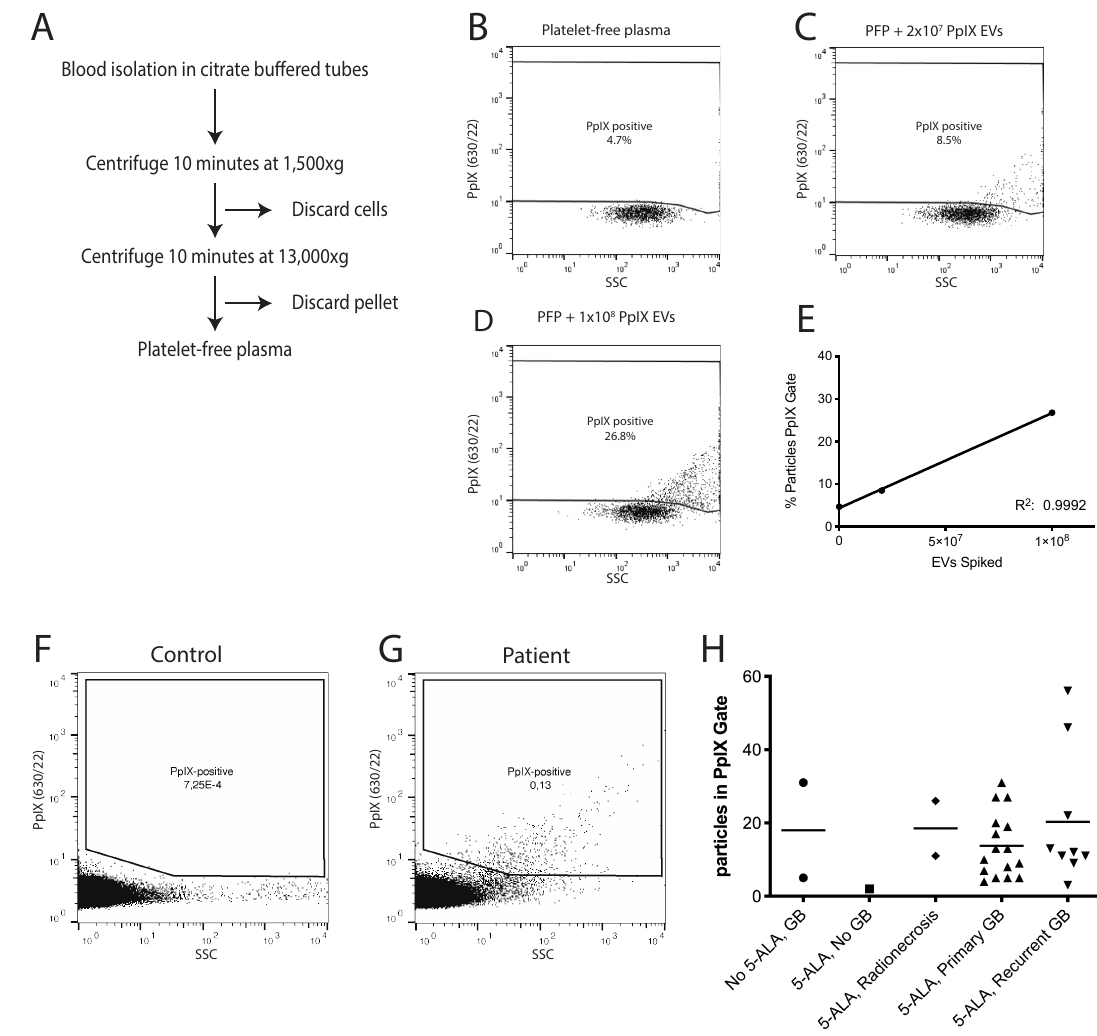
Figure2. IsolationofPpIX-positiveEVsfrompatientplasma.( A )Centrifugationprotocolfortheisolation of platelet-free plasma from whole blood. ( B ) hFC analysis of platelet-free plasma. ( C ) hFC analysis of platelet-free plasma spiked with 2 × 10 7 U87 derived PpIX-positive EVs. ( D ) hFC analysis of platelet-free plasma spiked with 1 × 10 8 U87 derived PpIX-positive EVs. ( E ) Linear regression plot of the % of particles in the PpIX gate versus the number of PpIX EVs spiked in. Goodness of fit, R 2 : 0.9998. ( F ) hFC analysis of PpIX particles in platelet-free plasma from control (10 min measurement). ( G ) hFC analysis of PpIX particles in platelet-free plasma from a patient treated with 5-ALA (10 min measurement). ( H ) Number of particles in the PpIX gate per patient group detected during 5 min of